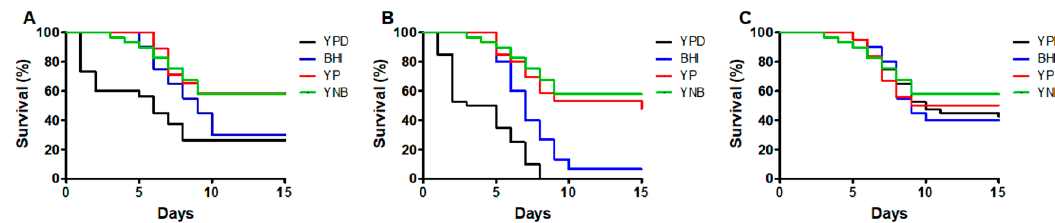
Figure 2. Comparison of the Sporothrix spp. ability to kill Galleria mellonella larvae. The data are the same as shown in Figure 1, but in this case, the mortality curves are grouped in one single chart for Sporothrix schenckii ( A ), Sporothrix brasiliensis ( B ), and Sporothrix globosa ( C ).